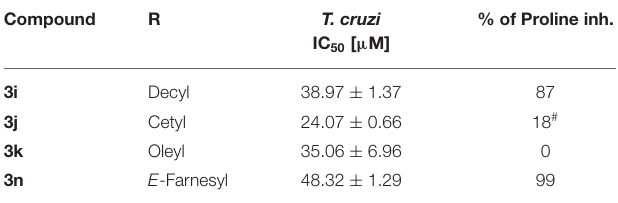
TABLE 2 | Proline uptake inhibition of selected